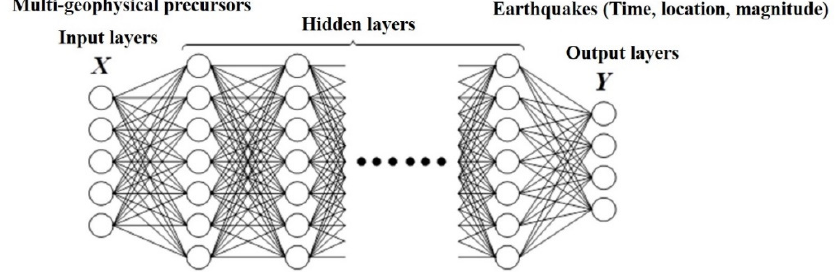
Figure 1. Earthquake forecast network based on machine learning.